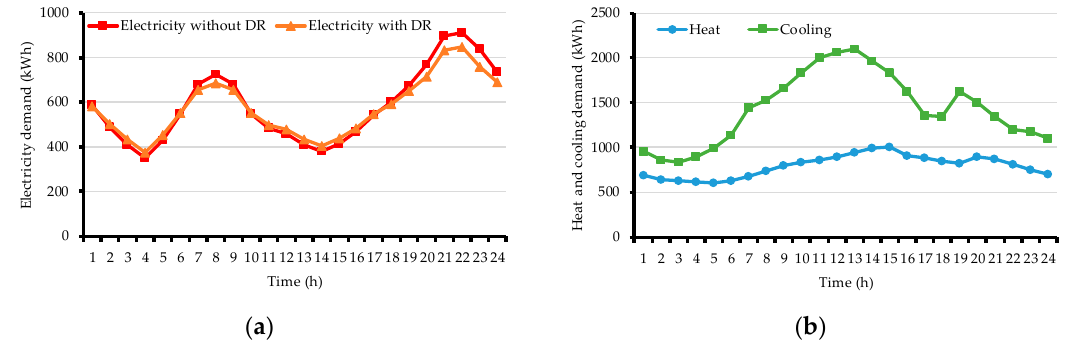
Figure 3. Energy demands of a typical summer day: ( a ) electricity demand and ( b ) heat and cooling demands.